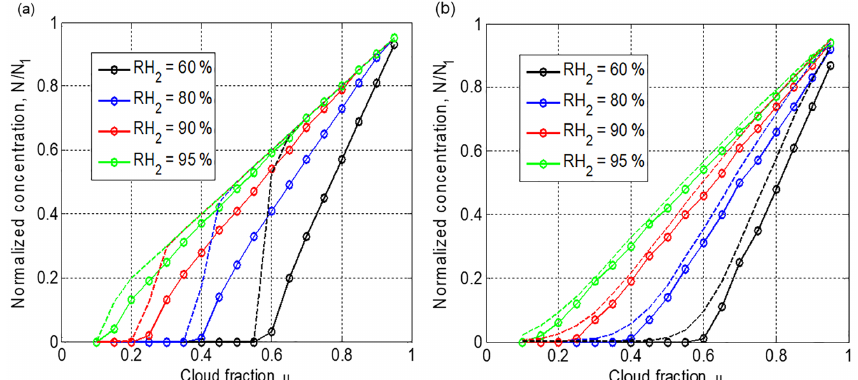
Figure 10. Final normalized droplet concentration vs. cloud fraction for initially narrow DSD (a) and initially wide DSD (b) . Parameters of initial DSD are shown in Table 1. Dashed line shows the results of equivalent homogeneous mixing. The initial mixing parameters are T = 10 ◦ C, p = 828.8mb and L =